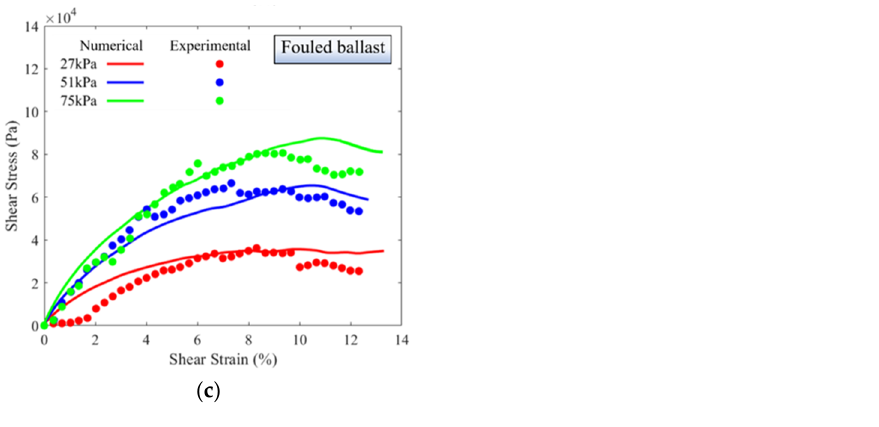
Figure 9. Shear response of fouled ballast for ( a ) VCI = 20%; ( b ) VCI = 40%; ( c ) VCI = 90%. Table 2. Micro-mechanical parameters for fouled ballast assembly. VCI Parameters Type of Contact Parameters Type of Contact Parameters Effective modulus, E* (Pa) Interparticle friction coefficient, μ